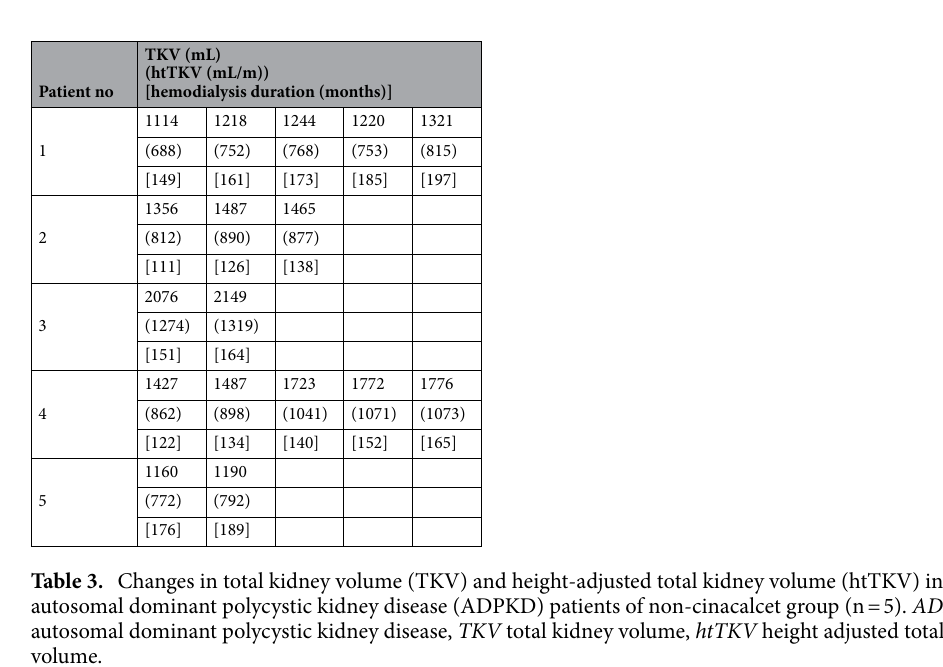
Table 2. Changes in total kidney volume (TKV) and height-adjusted total kidney volume (htTKV) in autosomal dominant polycystic kidney disease (ADPKD) patients of cinacalcet group (n = 7). ADPKD autosomal dominant polycystic kidney disease, TKV total kidney volume, htTKV height adjusted total kidney volume. *start of cinacalcet treatment.